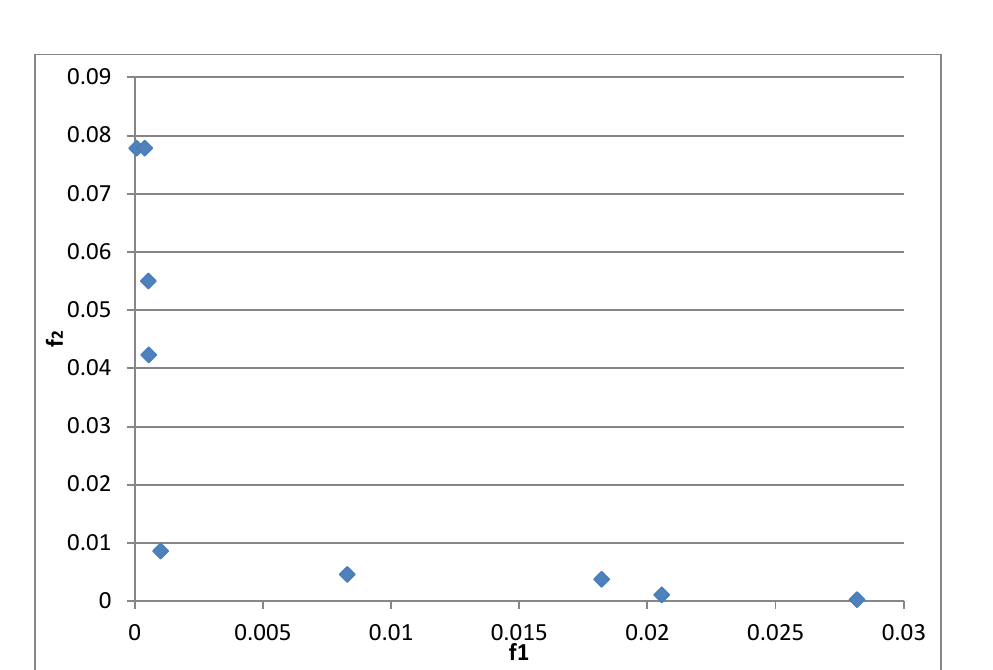
Figure 5. Pareto front obtained by MOPSO for Problem 3